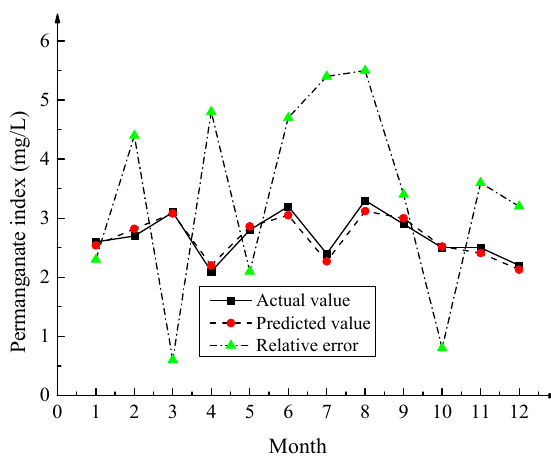
Figure 6. The prediction results of wavelet transform (WBPNN)for permanganate.